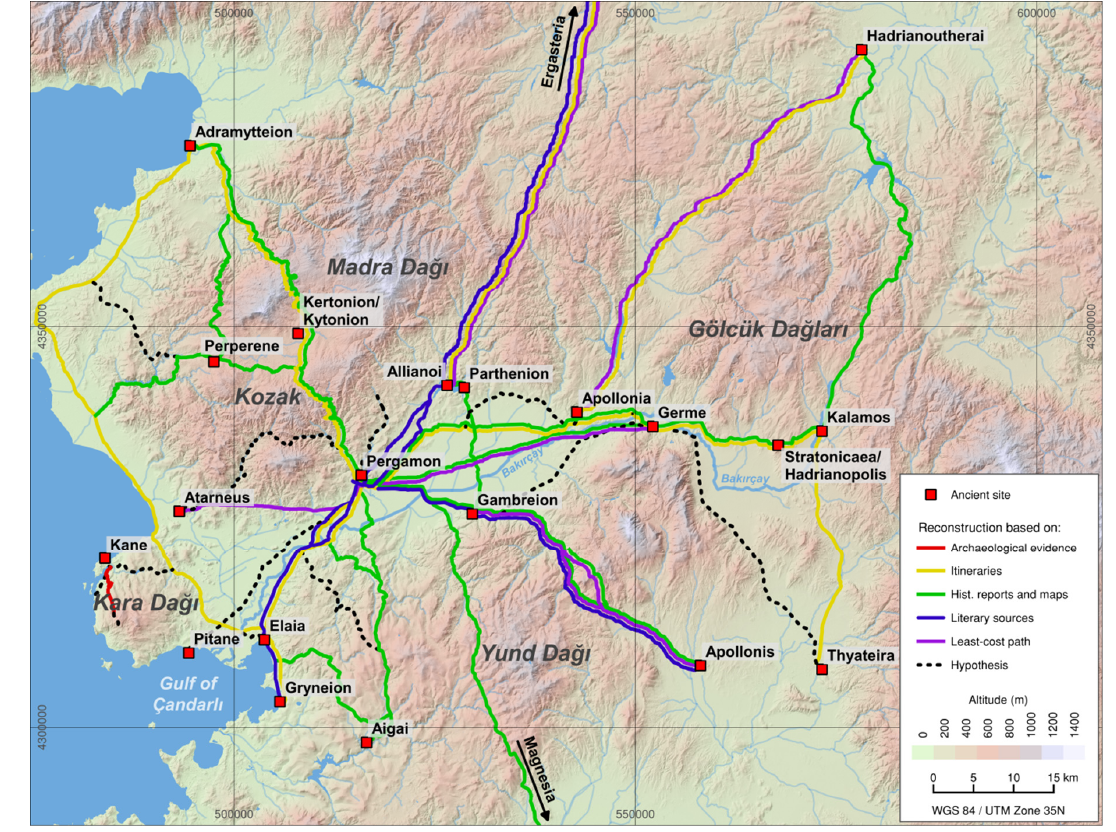
Figure 29. Reconstructed route network in Pergamon’s surroundings. Table 4. Reconstructed routes with their code and distance.